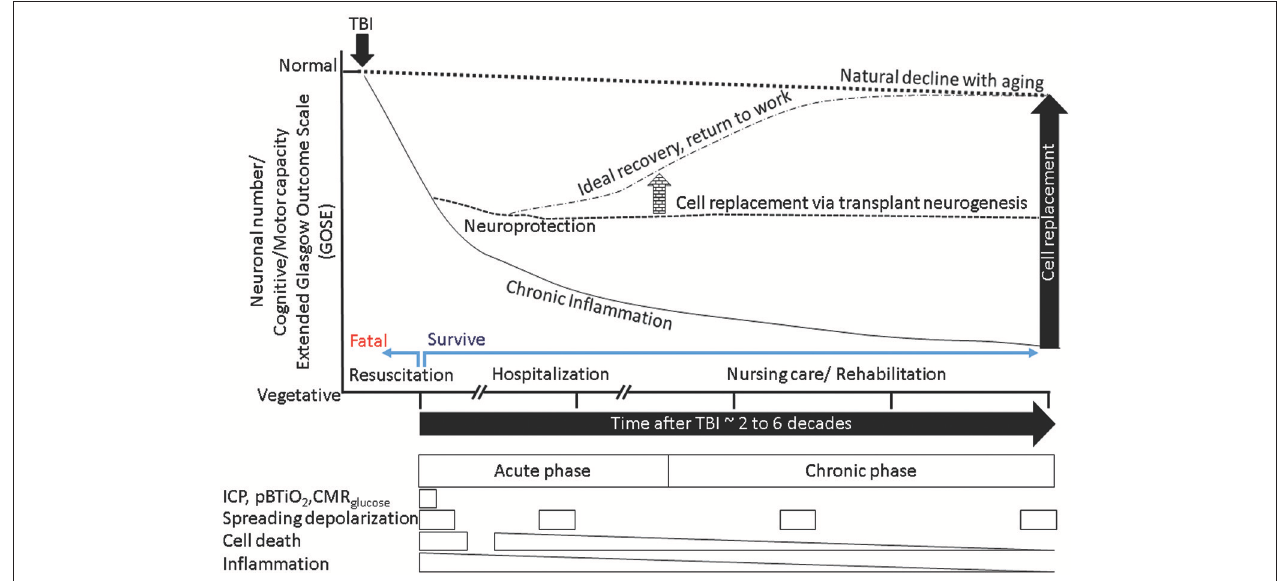
FIGURE 5 | A schematic summarizes the outcome of normal aging, accelerated aging following TBI, putative mitigation of disease progression by neuroprotection, and additional benefits from cell replacement. The x-axis represents time, the y-axis represents neuronal numbers and dependent behaviors ranging from normal at the top to vegetative at the bottom. The normal aging process produces a gradual decline (dotted outline) in cognitive and motor behaviors. Following a TBI (black arrow) the process of aging is accelerated (solid downward line), with chronic inflammation and tissue loss reducing ability. Successful resuscitation can help survive otherwise fatal TBI, if post survival hospitalization produces ideal recovery then return to work is possible (dotted-dashed line), mitigation of chronic inflammation via neuroprotective agents could stem tissue loss and stabilize ability (dashed line). If the neuroprotection is mediated by neural stem cells that have the potential to replace lost cells, the new tissue in conjunction with nursing care and rehabilitation may facilitate sufficient recovery that is indistinguishable from normal aging (arrow elevating the dashed line to dashed-dotted level). The boxes below represent the transient nature of various therapeutic windows. It is evident that therapeutic windows during hospitalization are short, while those associated with disability such as post-traumatic epilepsy (PTE)/seizures depend on incidence, each event if prevented by timely intervention could mitigate further decline in ability. Acute cell death is transient, however chronic inflammation and secondary cell death that are diminishing opportunities. Hence, only acute/sub-acute neuroprotection can afford maximum benefit. However, if the cell replacement can be exploited with rehabilitation in a timely manner, there is no limit to the therapeutic